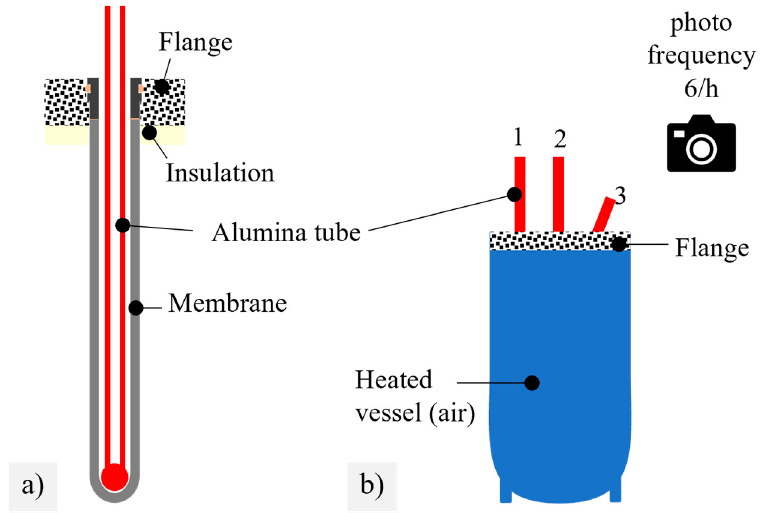
Figure 3. ( a ) Section through membrane loaded by alumina tube; ( b ) experimental view with failure of membrane 3. Drawings are not to scale. of membrane 3. Drawings are not to